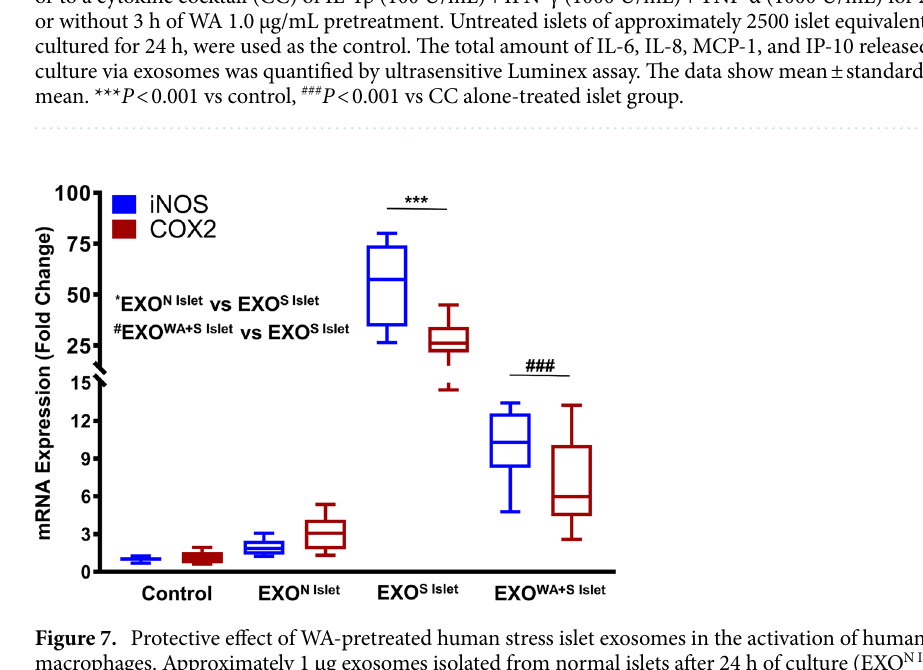
high-mobility group box 1 and isletokines in response to physiological stress, which facilitates an instant blood- mediated inflammatory reaction—an innate response leading to graft loss 27–29 . Moreover, we previously showed that cytokine-induced inflammation leads to induction of HLA class II expression on transplanted islet cells, potentially causing antidonor sensitization and adversely impacting allogeneic islet transplant outcomes 30 . Donor cell treatment with WA before allogeneic transfer significantly prevented GVHD-associated mortal- ity and decreased the levels of cytokines 26 . Our previous study also showed that WA did not affect viability or insulin secretory function but suppressed the release of inflammatory cytokines (MCP-1, IL-6, IL-8, IP-10) from isolated human islets in vitro 20 . The current study revealed that WA suppressed inflammatory cytokine release via exosomes in stressed human islets. It is known that IKKβ inhibitor (benzoxathiole) suppresses iNOS and COX-2 expression 31 . Indeed, several studies have shown that NF-κB directly binds to the iNOS and COX-2 promoter region and regulates transcription. Thus, we presumed that WA prevents activated macrophages, which have a central role in the innate immune response, from producing iNOS and COX-2 in inflammatory conditions 32,33 . As we expected, islets pretreated with WA produced less exosome in cytokine-induced stress conditions, which contributed to the suppression of macrophage activation. Given the contribution of islet derived factors including